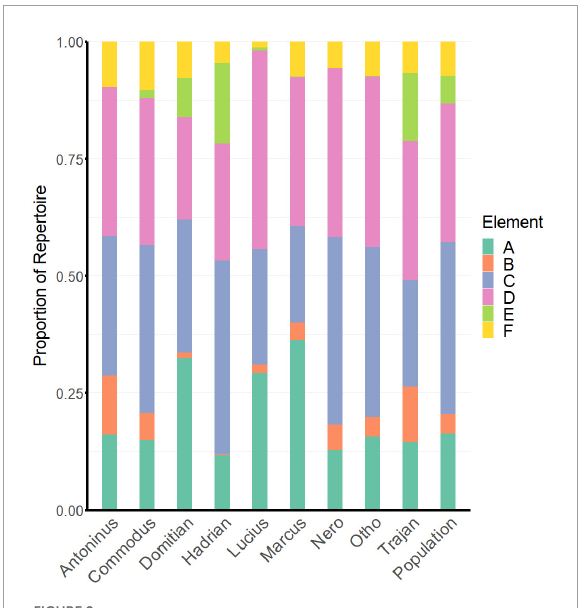
FIGURE2 The use of elements in song construction by individual bats and as a population average. A = trill; B = tone; C = upsweep; D = downsweep; E = click; and F =